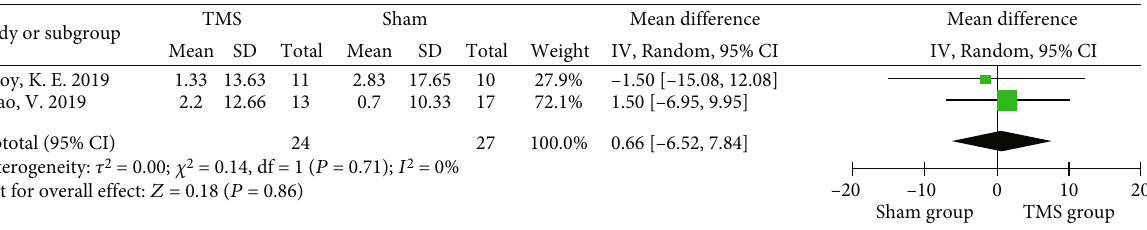
Figure 9: Forest plots of di ff erent parts of rTMS on cognition measured by the SCWT in TBI patients. SCWT: Stroop Color-Word